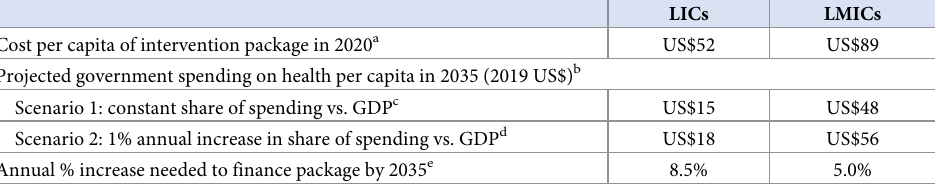
Table 1. Cost and affordability of essential non-COVID-19 health interventions in